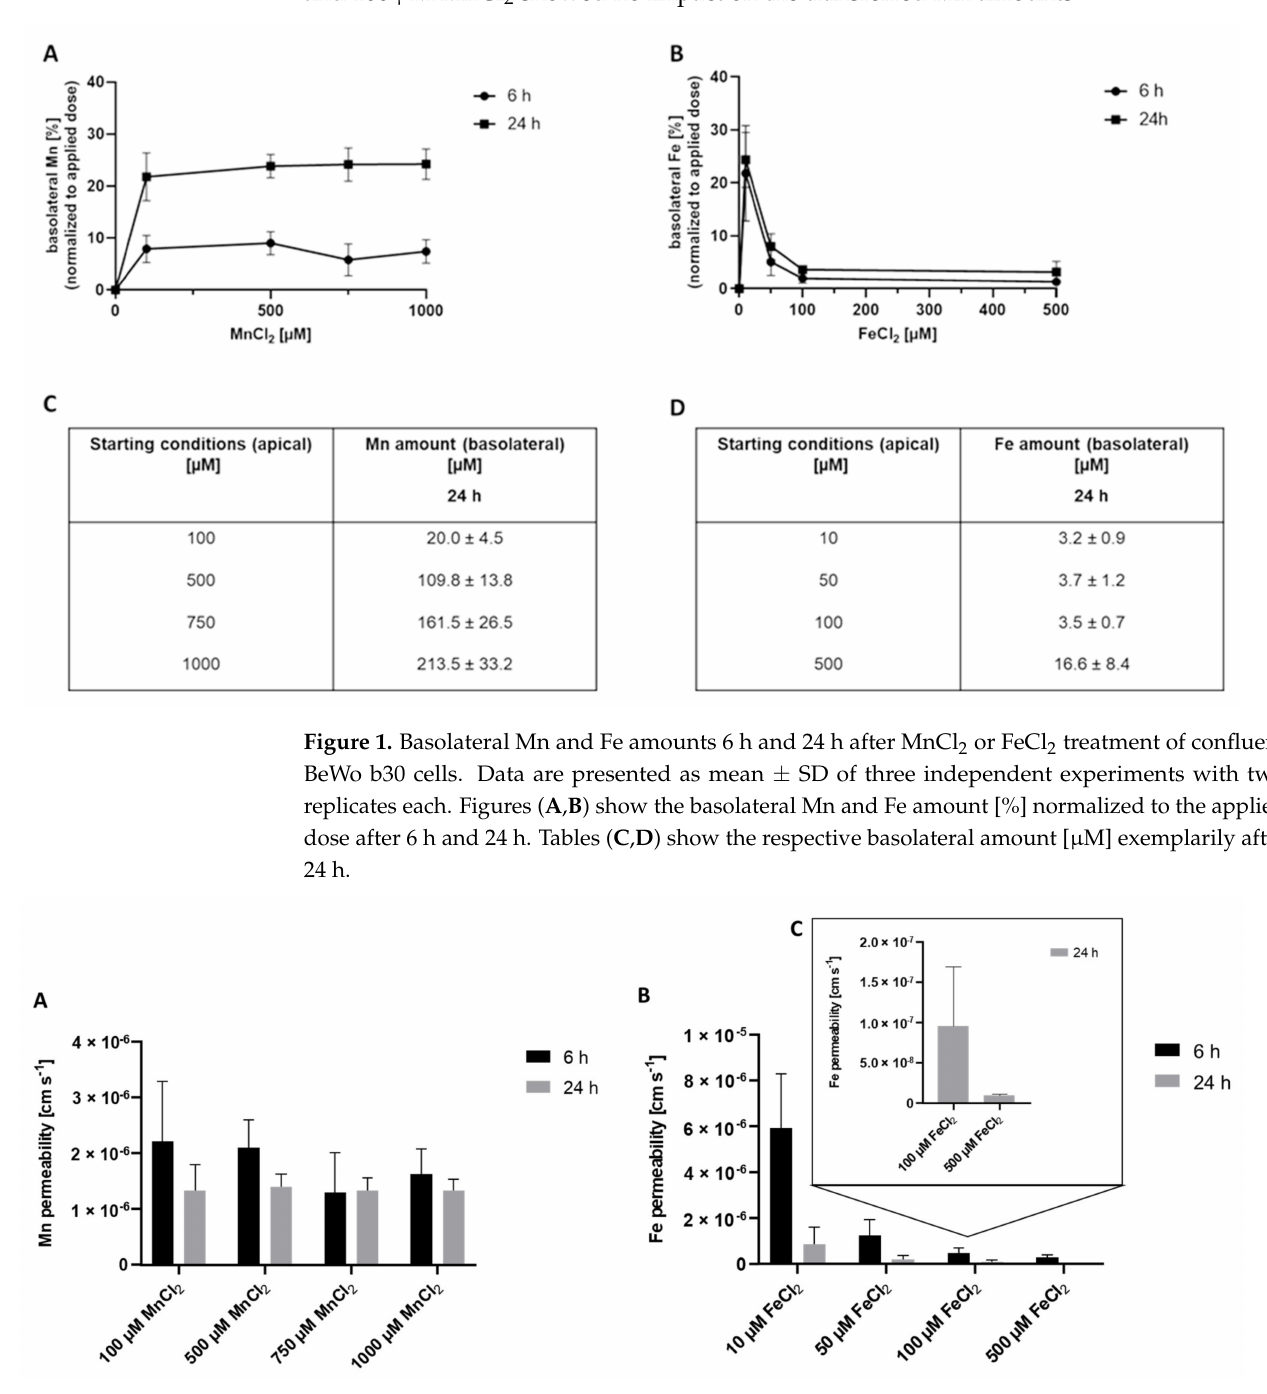
Figure 2. Mn and Fe permeability coefficients across the confluent BeWo b30 cell layer. Permeability was determined in regards to apical Mn or Fe treatment after 6 h and 24 h. Shown is the mean + SD of at least three replicates each. ( A ) Mn permeability, ( B ) Fe permeability, ( C ) enlarged section of permeability coefficients of 100 µ M FeCl 2 and 500 µ M FeCl 2 after 24